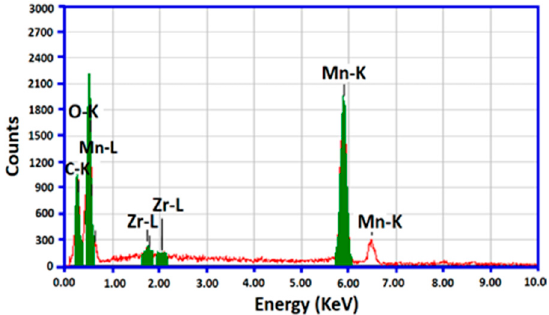
Figure 6. Energy dispersive X-ray spectroscopy (EDX) indicating the chemical composition of the (1%)ZrO x –MnCO 3 /(1%)GRO nanocomposite.